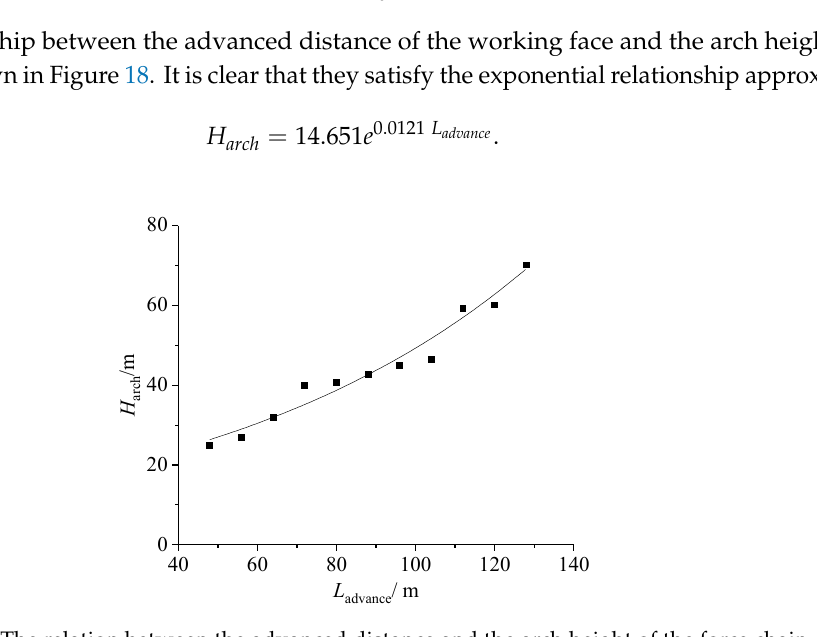
Figure 18. The relation between the advanced distance and the arch height of the force chain.